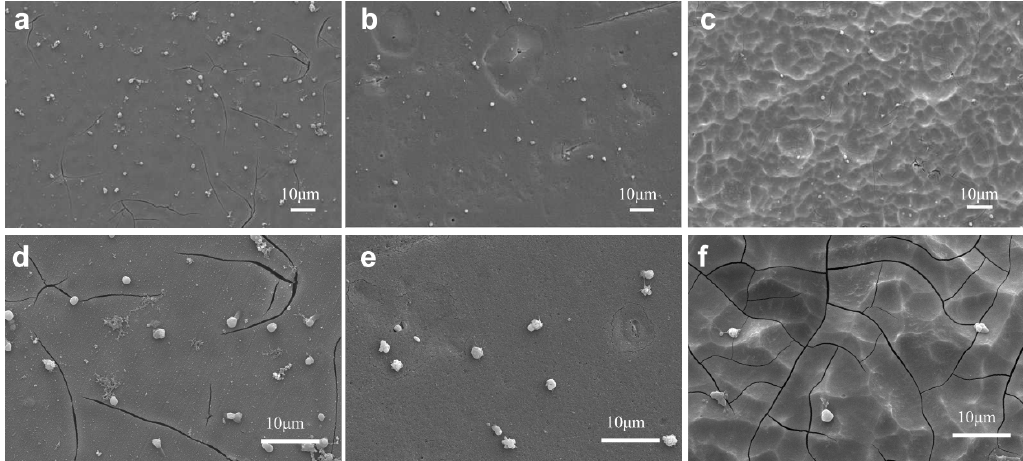
Figure 7. The typical SEM images of the adhered platelets on AZ31B ( a , d ), Mg–OH ( b , e ) and Mg–HF ( c , f ).